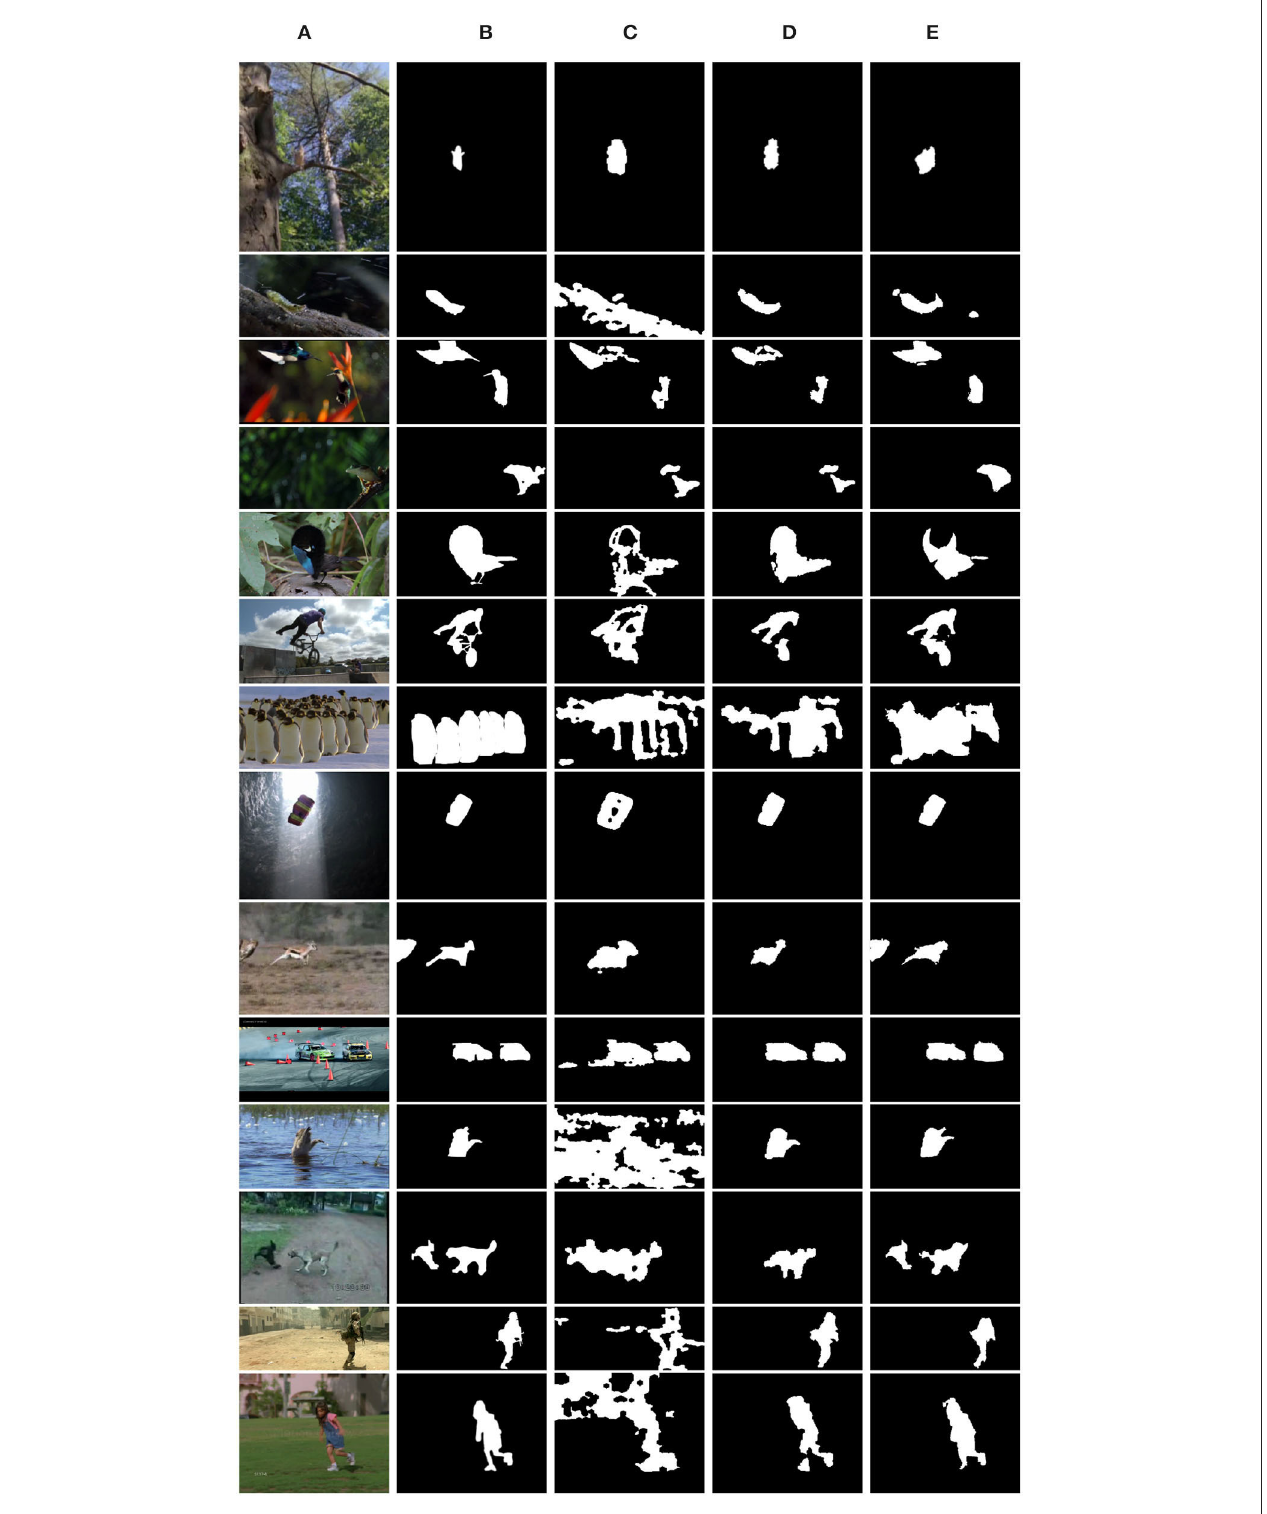
FIGURE 9 | Sample results on S egTrackv2 dataset for sequences acquired with a fixed camera (from top birdfall , worn , hummingbird , and frog ), hand-held camera ( bird of paradise , bmx , penguin , and parachute ), and dynamic cameras ( cheetah , drift , monkey , monkeydog , soldier , and girl ). (A) Reference frame, (B) ground truth, (C) our results (motion), (D) our results (motion+objectness), and (E) Zhuo et al.